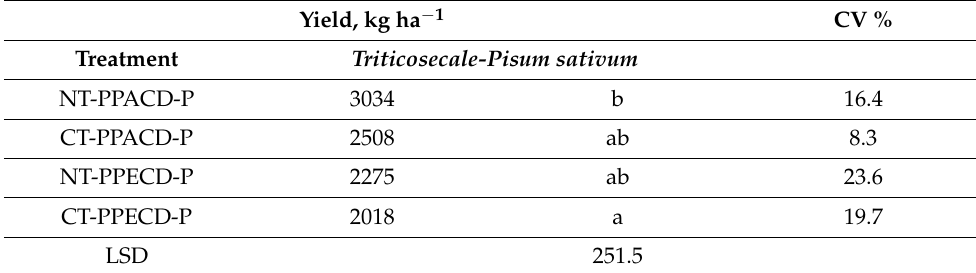
Table 9. Biomass of the intercropping Triticosecale–Pisum sativum cultivation (kg ha − 1 ) under different soil practices during the 1st